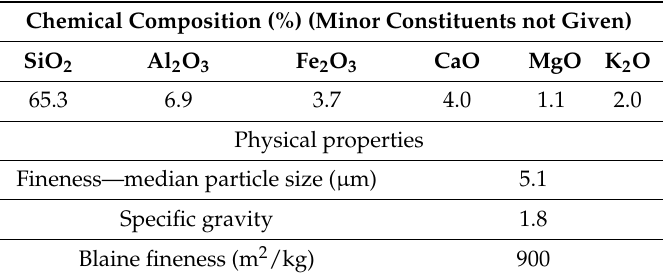
Table 5. Typical chemical and physical properties of sugarcane bagasse ash [56].